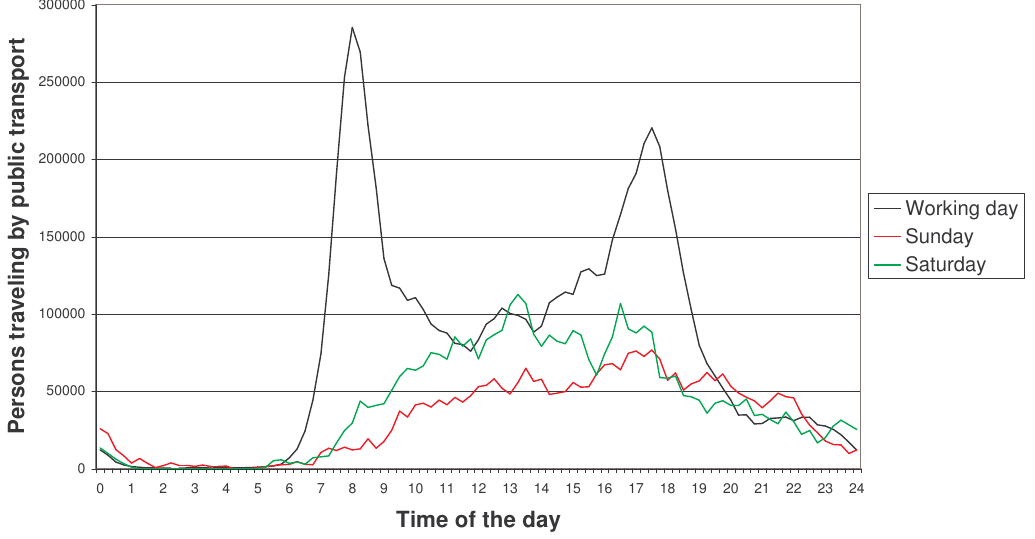
Figure 1. Temporal distribution of Dutch public transport ridership in 1998 The degree of fluctuation is highest in regional transport and smallest in long distance transport. Interestingly, the distribution of travellers of all modes, travelling at least 2 km, varies less than the distribution of only public-transport users. This is also true for